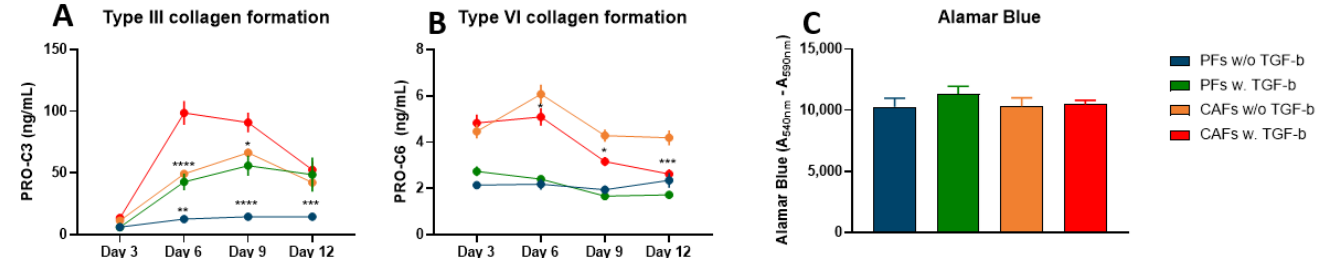
Figure 2. Fibrotic potential and metabolic activity in quiescent pancreatic fibroblasts (PFs) and pancreatic cancer-associated fibroblasts (CAFs) treated with TGF-ß1. PRO-C3 ( A ) and PRO-C6 ( B ) were measured in supernatant from PFs without TGF-ß1, PFs treated with TGF-ß1, CAFs without TGF-ß1 and CAFs with TGF-ß1 on day 3, 6, 9, and 12 after initiation of experiment. ( C ) At day 12 metabolic activity was assessed using Alamar Blue. n = 2–6 technical replicates and 3–5 biological replicates. * p < 0.05. ** p < 0.001. *** p < 0.001. **** p < 0.0001. A p < 0.05 was considered significant.